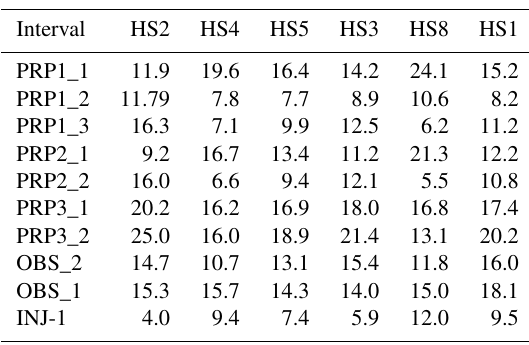
Table A2. Radial distances between the midpoints of the pressure monitoring intervals and the injection interval for all HS tests. The OBS intervals represent the inactive INJ